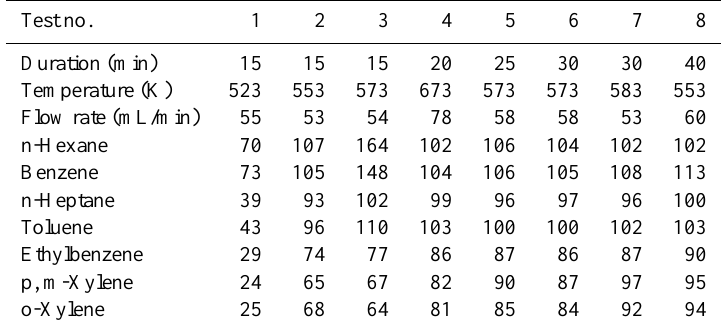
∗ Results are based on one measurement.